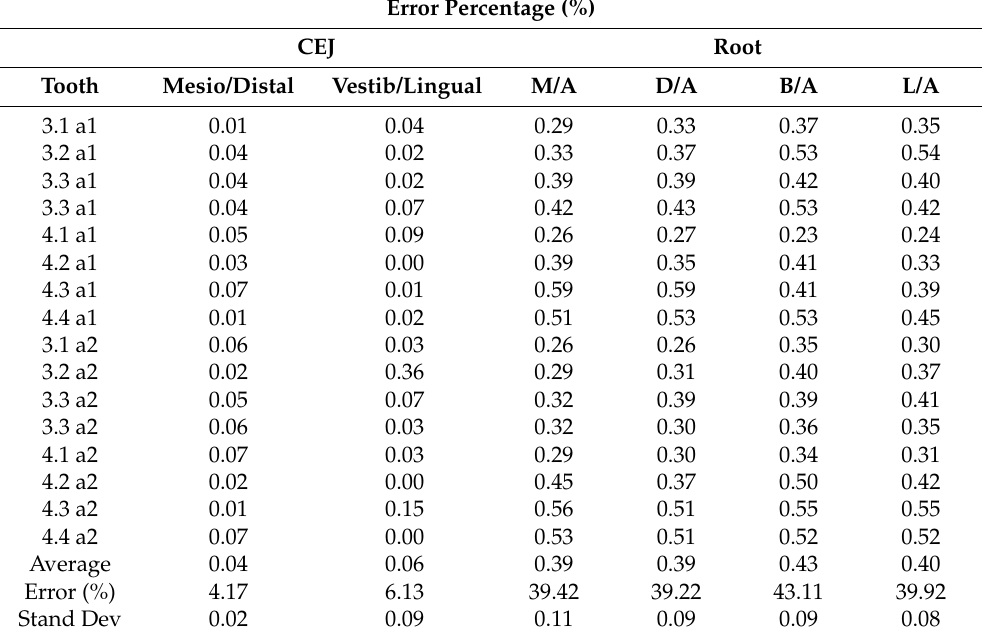
Figure 4. Comparison of natural teeth once extracted and their 3D replicas: ( a ) first lamb skull; ( b ) second lamb skull. Table 1. Cement–Enamel Junction (CEJ) and Root percentage error evaluation at mesial, distal, buccal, and lingual points in all natural tooth and replica specimens. All measurements were calculated using the aforementioned formula. Legend: a1 = lamb skull 1; a2 = lamb skull 2; M/A = mesial point and apex; D/A = distal point and apex; B/A = buccal point and apex; L/A = lingual point and apex. Error Percentage